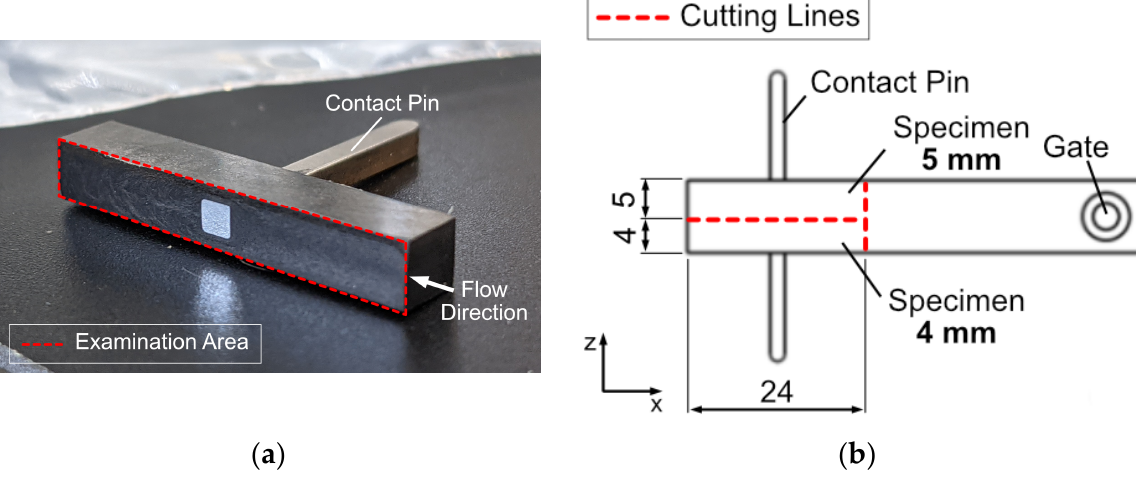
Figure 3. ( a ) Examination area on a prepared specimen. ( b ) Dimensions of a prepared specimen and cutting lines for precision sectioning.